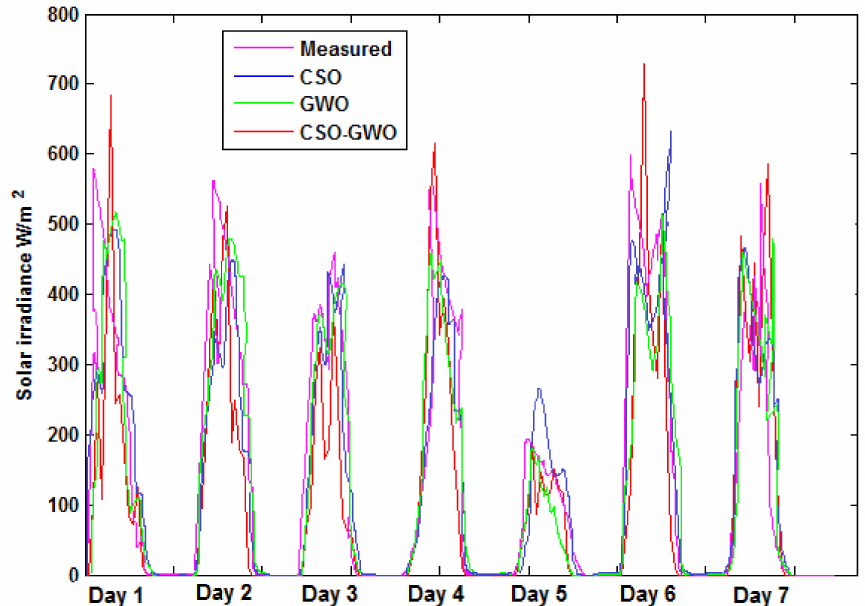
Figure 8. Daily prediction of solar irradiance using CSO, GWO, and hybrid CSO-GWO with